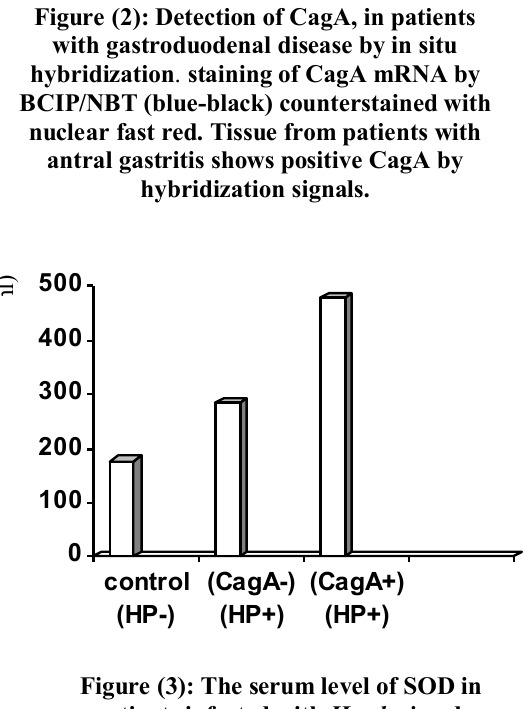
Figure (3): The serum level of SOD in patients infected with H.pylori and CagA